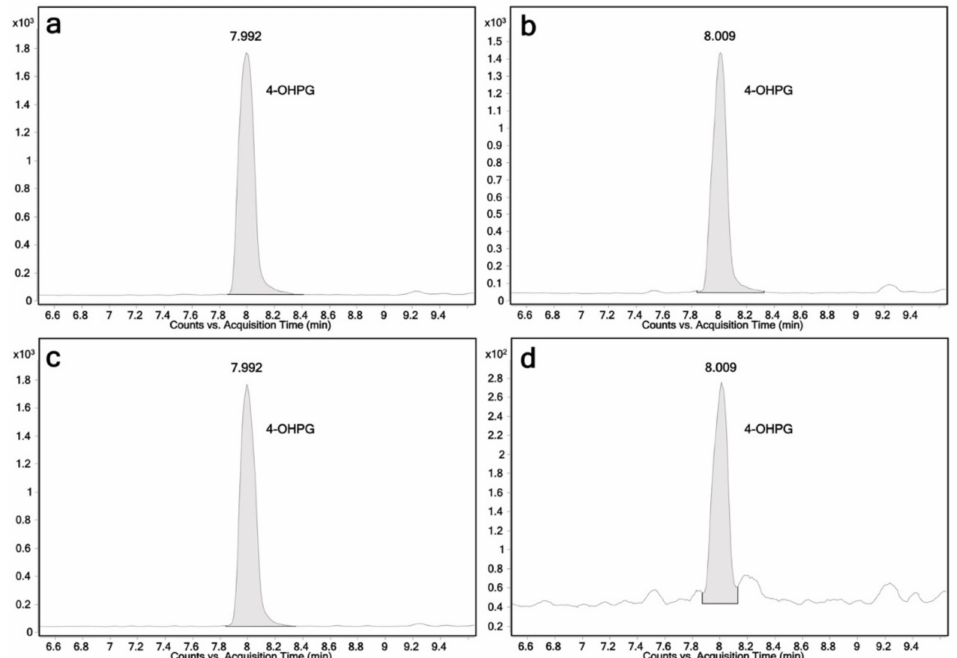
Figure 4. Chromatograms of 4-hydroxypropranolol glucuronide obtained from individual UGT reactions monitoring the ion transition m / z 452 → 116; 4-OHPG: 4-hydroxypropranolol glucuronide, retention time 8.0 min; ( a ) UGT1A7; ( b ) UGT1A8; ( c ) UGT1A9; ( d )